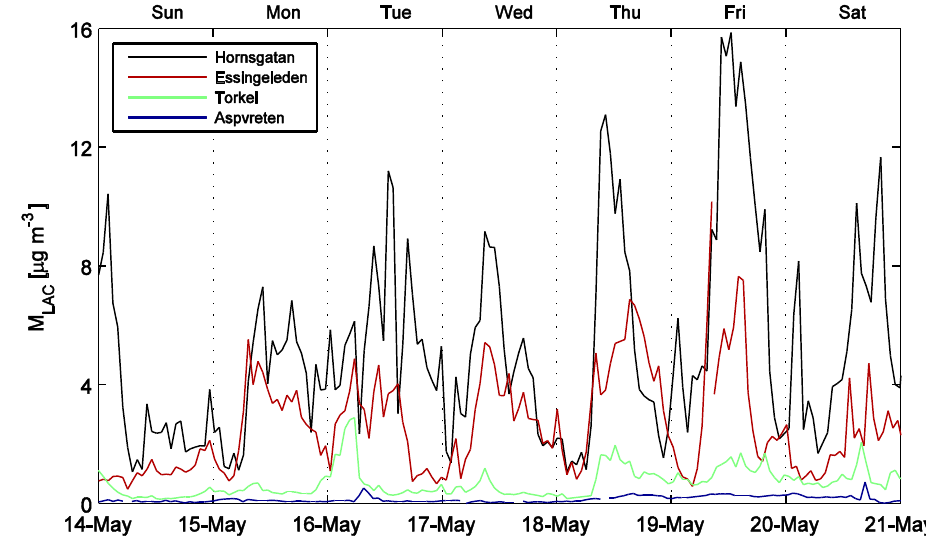
Fig. 5. Time series of hourly mean M LAC concentrations at the four sites for the period 14–20 May 2006. Date labels are at 00:00LT. Days Fig. 5 of the week are also